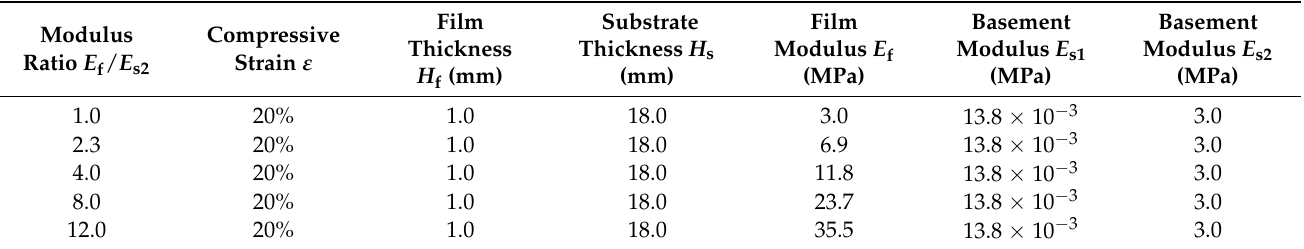
Figure 5. Influence of modulus ratio E f / E s2 on the composite instability morphology. Table 3. Different elastic modulus ratios, E f / E s2